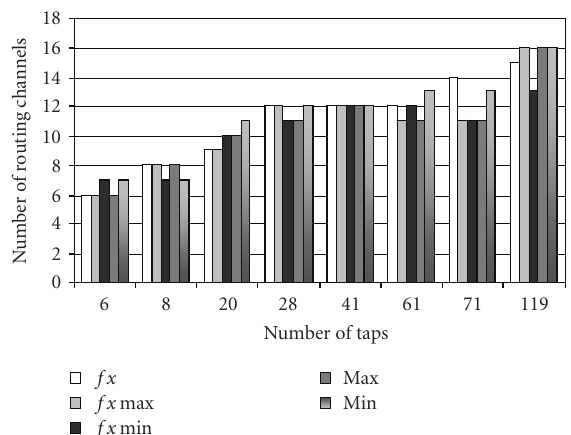
Figure 17: Number of routing channels versus filter size for various cost functions discussed in Section 4.3 with f x being the modified CSE algorithm presented in Algorithm 1 and others based on maximizing or minimizing AMC. f xmin is the best scenario that results in the minimum number of routing channels.